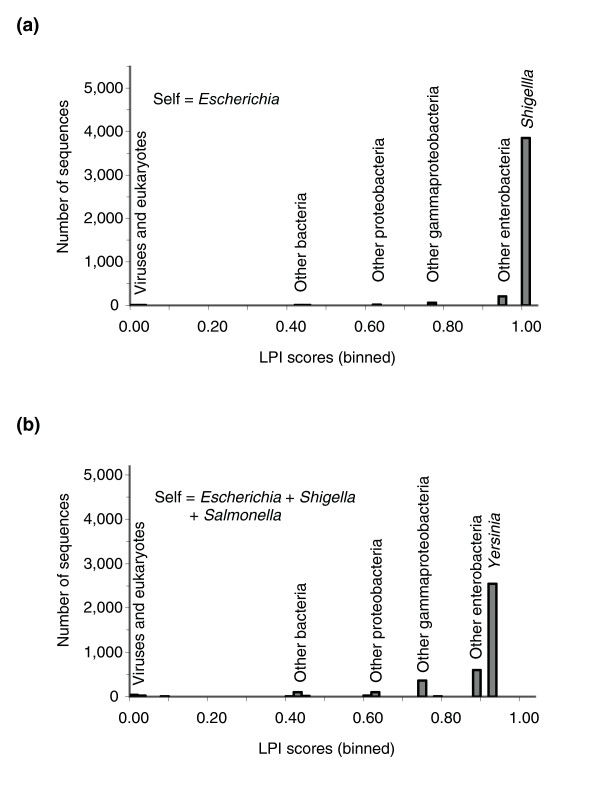
Effect of expanding E. coli self definition terms on LPI score distribution histograms. Filter threshold setting was 10%. (a) Self = Escherichia (b) Self = Escherichia + Shigella + Salmonella.